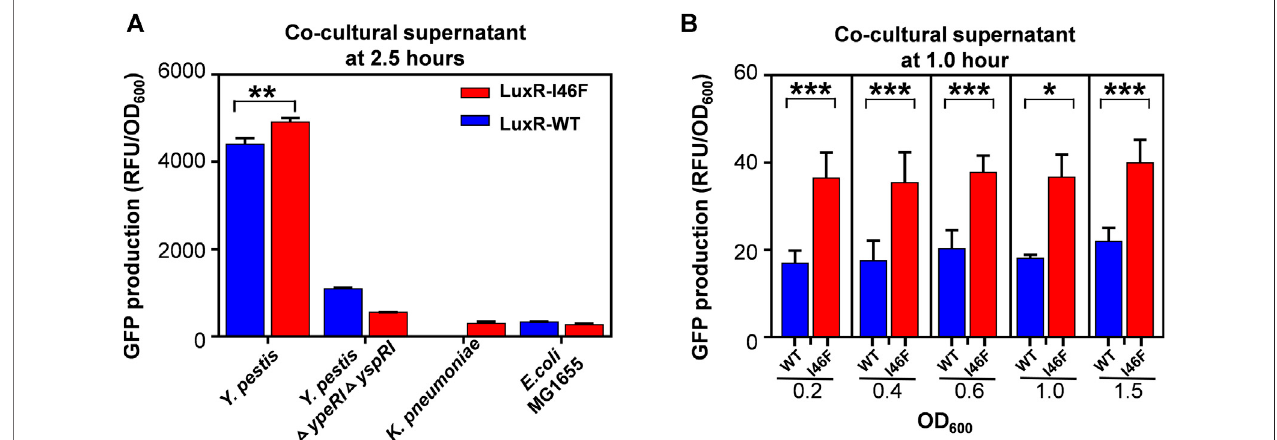
FIGURE 5 | (A) Relative fl uorescence intensity of the biosensors based on LuxR-WT and LuxR-I46F incubated in culture supernatant of Yersinia pestis (OD 600 (cid:2) 1.4), Y. pestis Δ ypeRI Δ yspRI (OD 600 (cid:2) 1.4) , K. pneumoniae (OD 600 (cid:2) 0.7), or E. coli strain MG1655 (OD 600 (cid:2) 0.7) for 2.5 h. (B) Relative fl uorescence intensity of the biosensors based on LuxR-WT and LuxR-I46F incubated in culture supernatant of Y. pestis or Y. pestis Δ ypeRI Δ yspRI (OD 600 (cid:2) 0.2, 0.4, 0.6, 1.0, or 1.5) for 1 h. The results are the means of triplicate experiments.